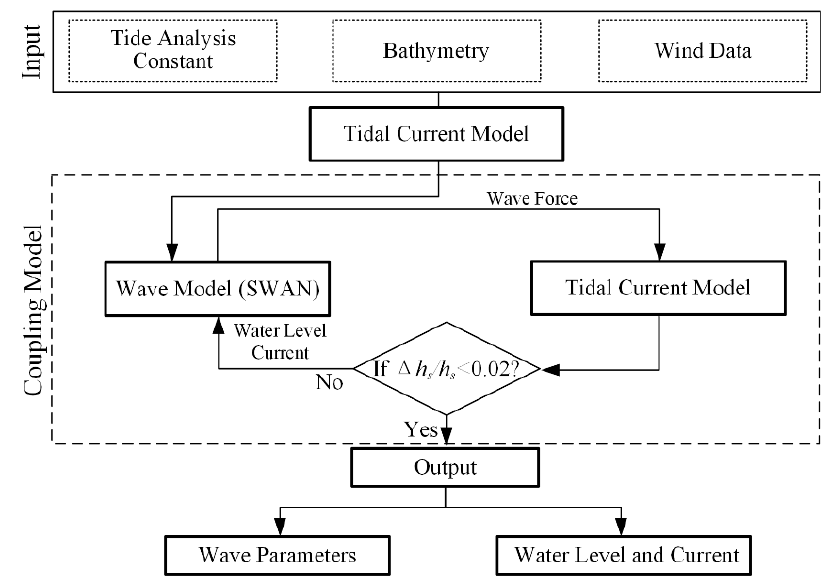
√ indicates the sub-model and driving